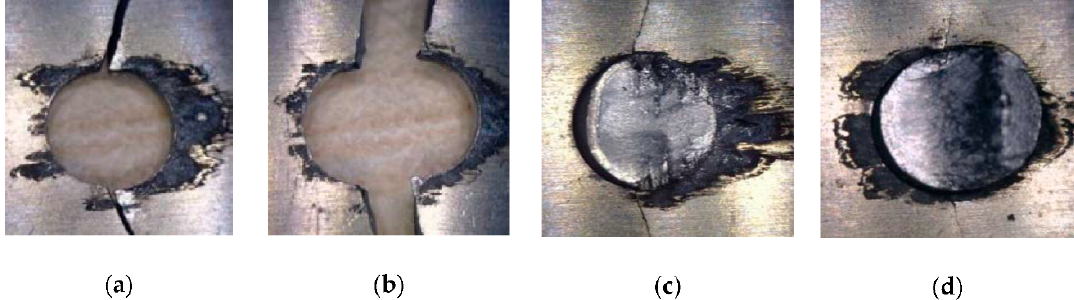
Figure 20. Fatigue failure morphology of riveted lap joints in different riveting directions: ( a ) fatigue failure morphology of riveted joints of 1° in the 0° direction (0-1); ( b ) fatigue failure morphology of riveted joints of 1° in the 180° direction (180-1); ( c ) fatigue failure morphology of riveted joints of 2° in the 0° direction (0-2); ( d ) fatigue failure morphology of riveted joints of 2° in the 180° direction (180-2).